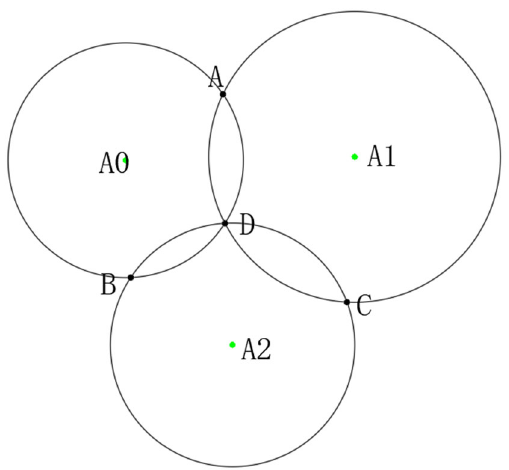
Figure 6. Schematic diagram of the positioning of normal data (The letters on the figure indicate the centers of the three circles or the points of intersection on the circles). centers of the three circles or the points of intersection on the